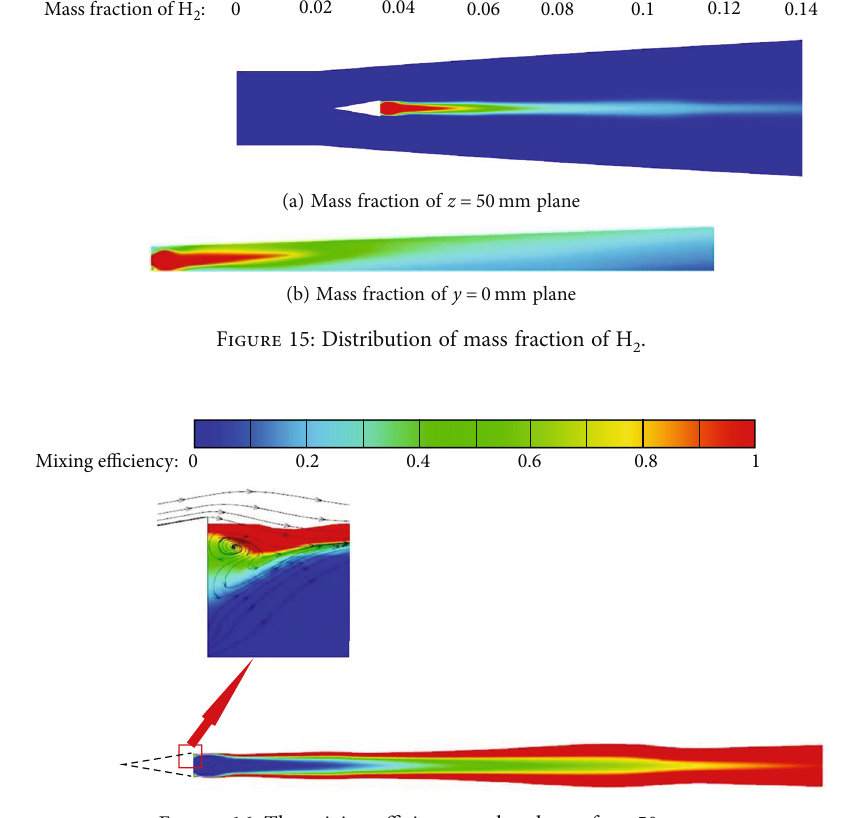
Figure 16: The mixing e ffi ciency at the plane of z = 50 mm